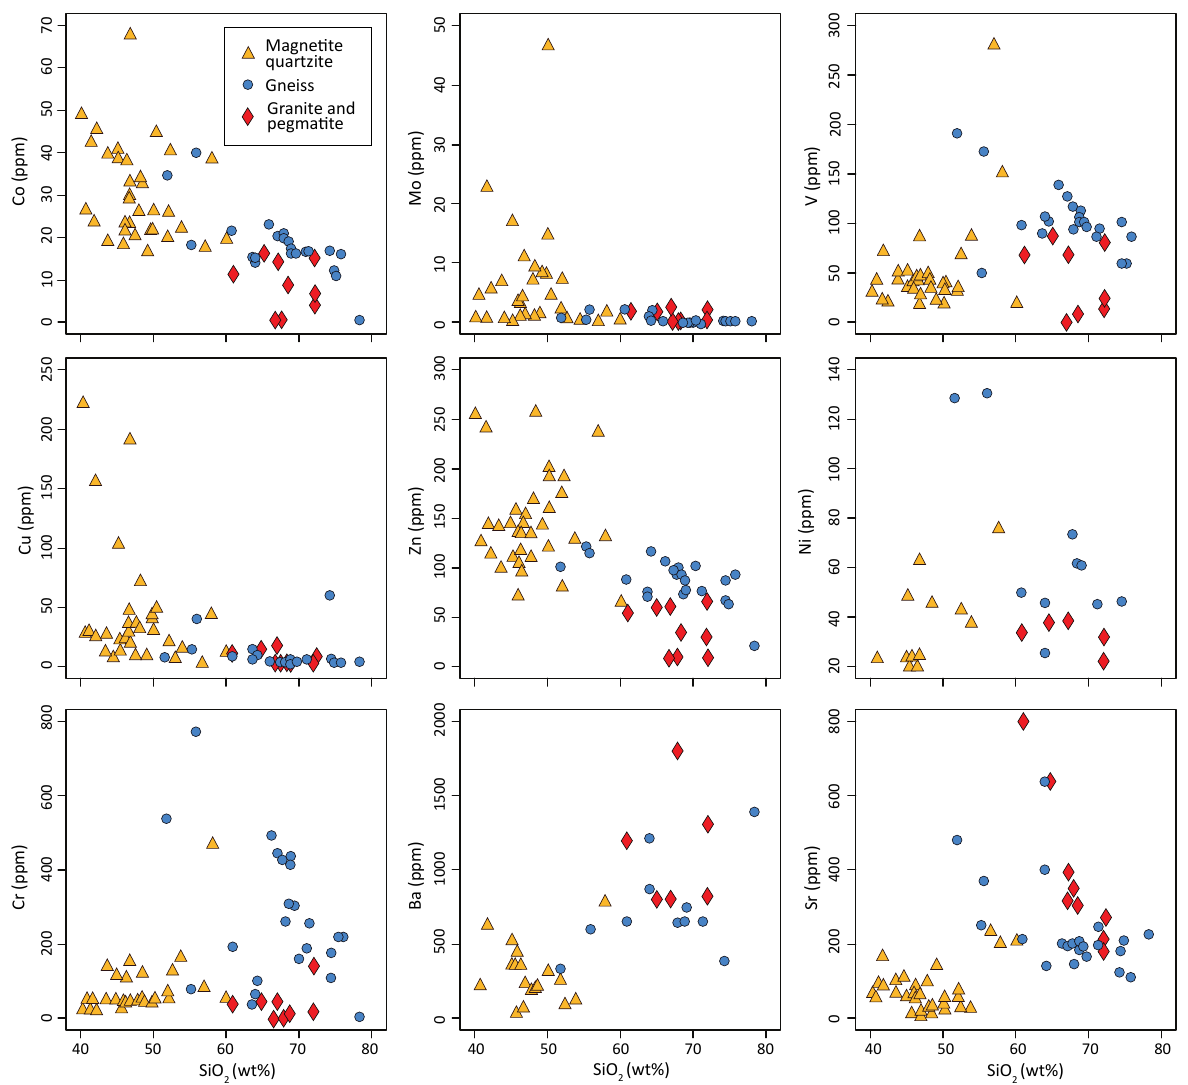
Fig. 6. Geochemical variation plot for selected trace elements in the Jõhvi Zone rock types (in ppm). Selected geochemical analyses in Table 1; full set of analyses at